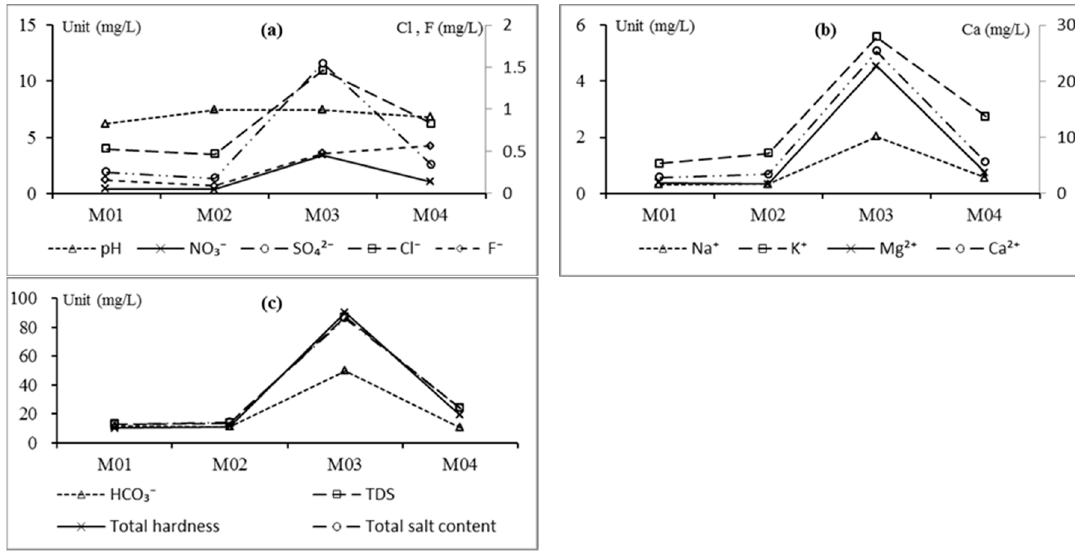
Figure 4. Changes in the concentrations of the main hydrochemical components of groundwater (( a – c ) represent the change in the content of each ion).